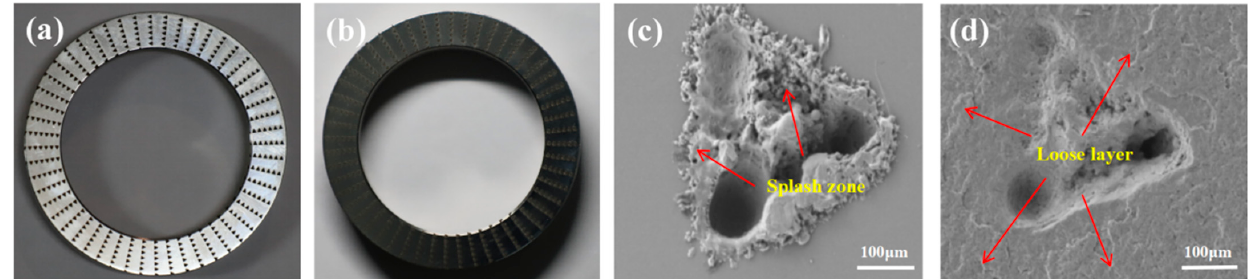
Figure 9. Test sample appearance diagram. ( a ) Substrate texture. ( b ) Nitriding texture. ( c , d ) are enlarged images of the individual textures in ( a , b ).